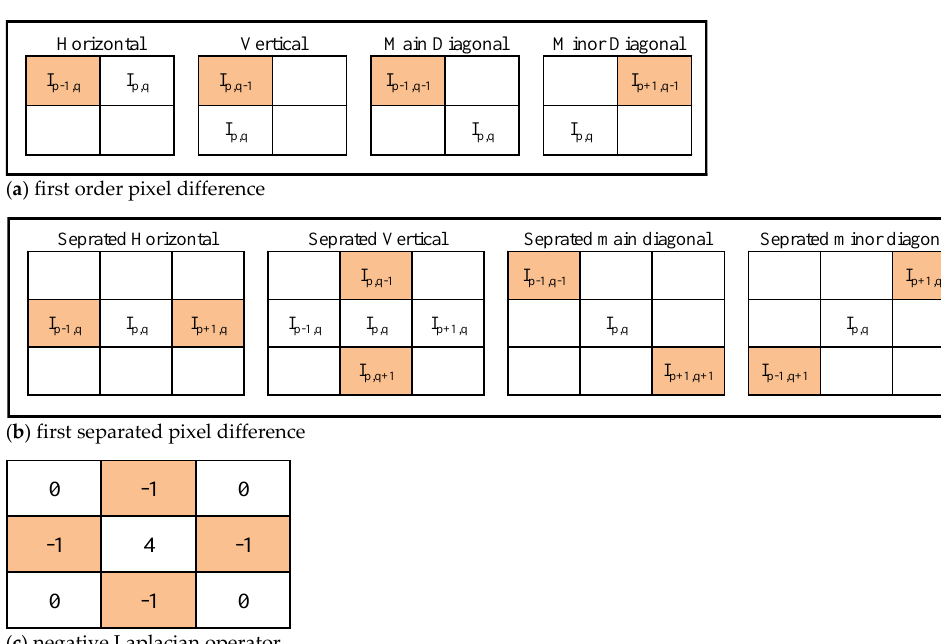
Figure 5. Pixel differences: ( a ) first order pixel difference; ( b ) separated pixel difference; ( c ) negative Laplacian operator.